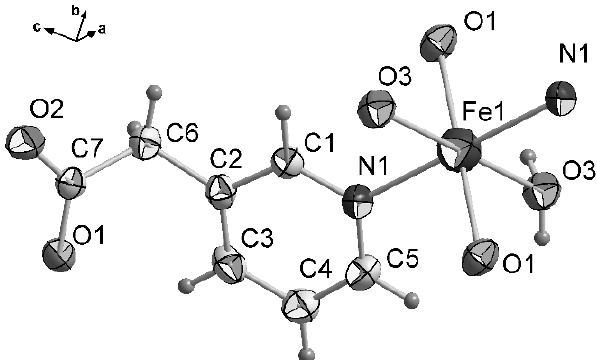
and adopts distorted octahedral coordination by two nitrogen